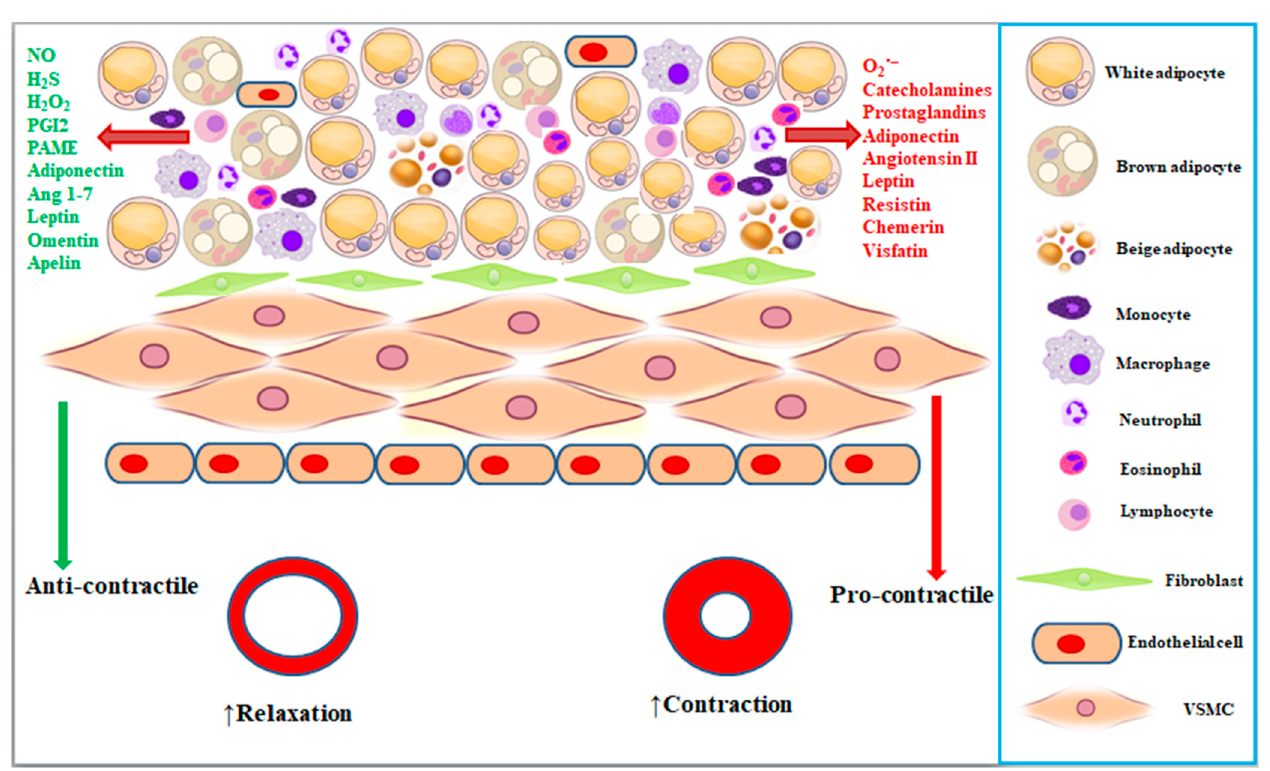
Figure 1. Blood vessels are made up of three cellular layers, namely intima (endothelial cells), media (VSMCs) and adventitia (fibroblast), and are surrounded by a fourth layer of adipose tissue called PVAT. PVAT is characterized by cellular heterogeneity harbouring adipocytes, endothelial and immune cells. PVAT regulates vascular tone via the secretion of vasoactive substances and adipokines. These factors, either anti-contractile or pro-contractile, decrease or increase the contractility of VSMCs, respectively. Ang 1-7, Angiotensin 1-7; PAME, palmitic acid methyl ester; PGI2, prostacyclin I 2 ; VMSC, vascular smooth muscle cell.